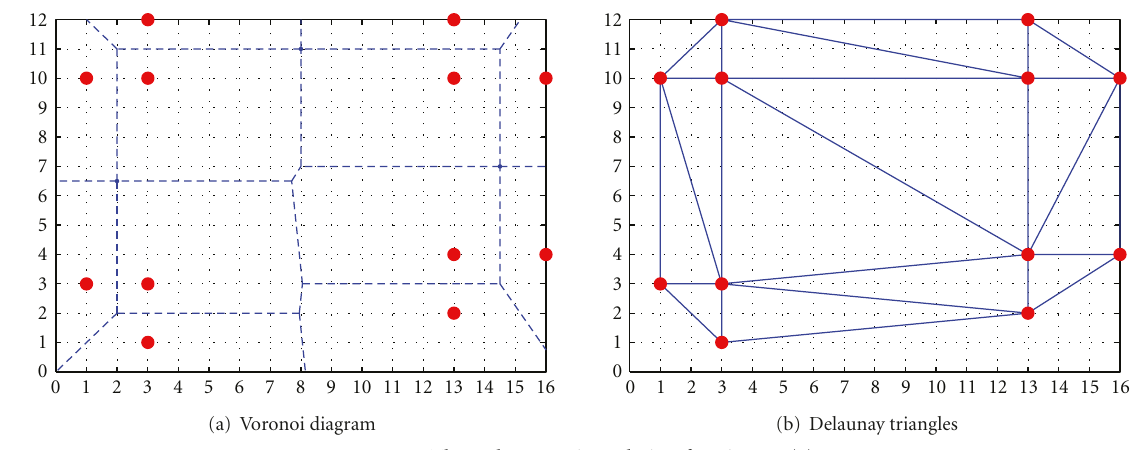
Figure 7: The Delaunay triangulation for Figure